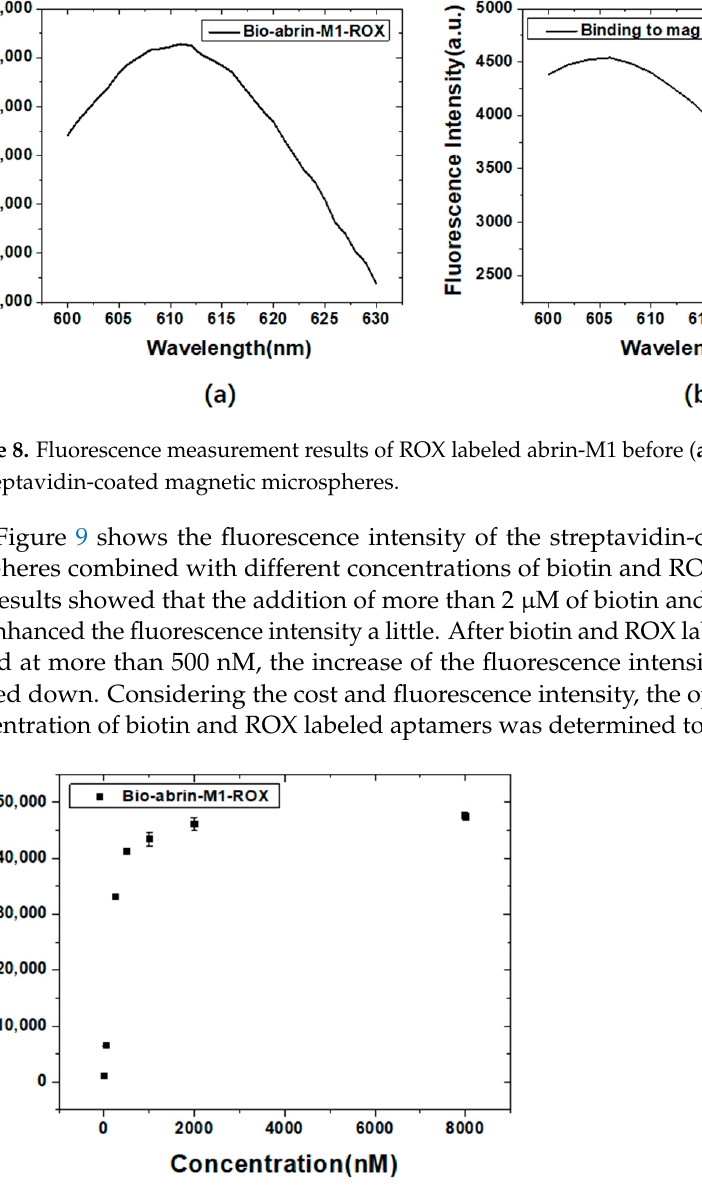
Figure 9. The fluorescence intensity of streptavidin-coated magnetic microspheres combined with different concentrations of biotin and ROX labeled abrin-M1.